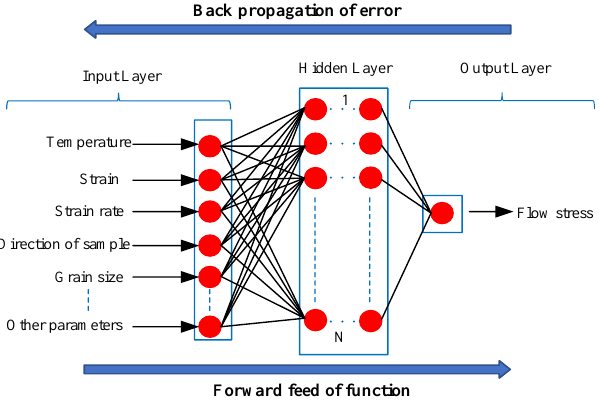
Figure 22. Schematic diagram of the BP neural network model.